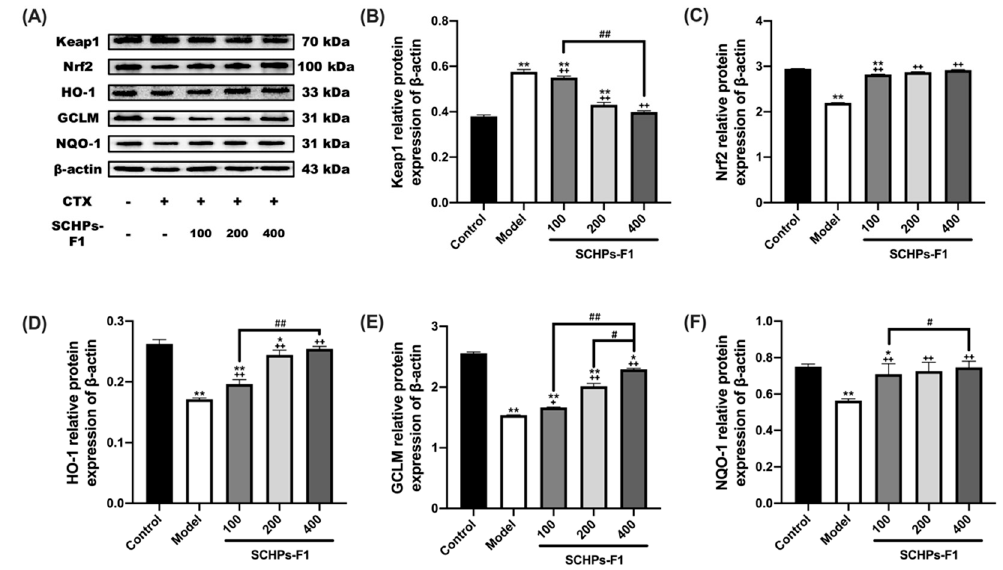
Figure 8. SCHPs-F1 treatment down-regulated Keap1 ( A , B ) and up-regulated Nrf2 ( A , C ), HO-1 ( A , D ), GCLM ( A , E ), and NQO-1 ( A , F ) protein levels in CTX-induced renal. * P < 0.05, ** P < 0.01, vs. control group; + P < 0.05, ++ P < 0.01, vs. model group; # P < 0.05, ## P < 0.01 indicate significant differences between different SCHPs-F1 dose groups.